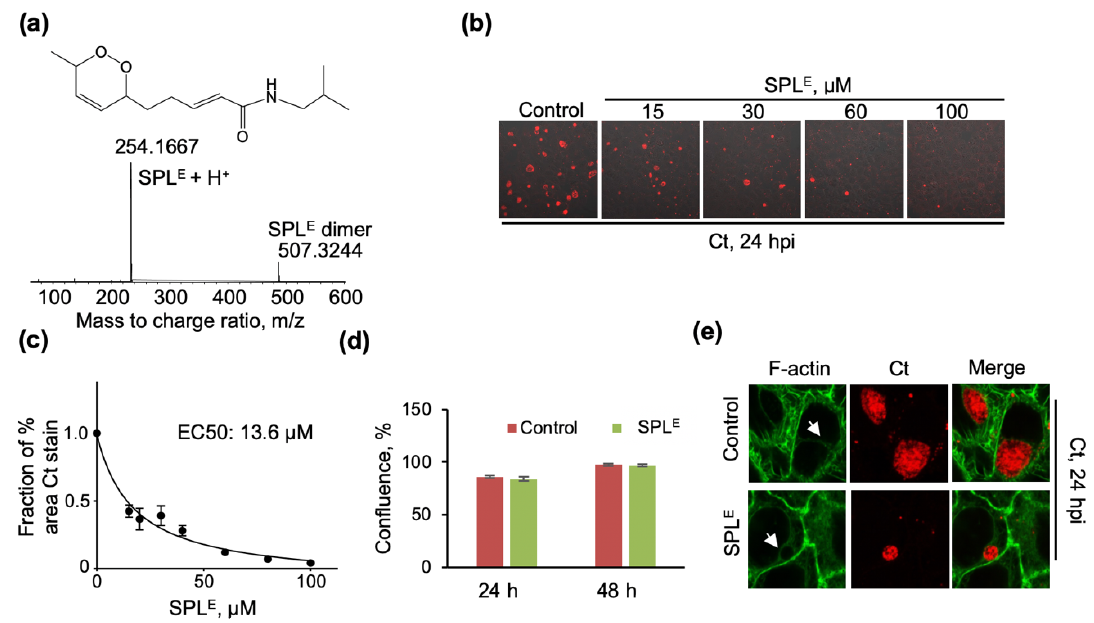
Figure 3. SPL E shows more potent inhibition of Ct infection ( a ) Chemical structure and ESI-TOF MS data of SPL E synthesized as described in Materials and Methods. MS data also shows the presence of SPL E dimer formed under the ESI-TOF MS conditions; ( b ) Confocal microscopy imaging of cells infected with Ct and SPL E vehicle (0.1% DMSO) at 24 hpi (control) or with SPL E followed immediately by infection with Ct and similarly imaged at 24 hpi. Chlamydial inclusions were visualized with anti-chlamydial major outer membrane protein (MOMP) antibody (red) and the image was overlayed with phase contrast images of cells; ( c ) Inhibition of Ct infection by SPL E was quantified by calculating the % area stained with anti-MOMP and representing the data as a fraction of vehicle control (n = 3 biological replicates, 3–6 imaging areas per biological replicate); ( d ) The effects of SPL E (120 μ M) on the proliferation of HeLa cells in the absence of Ct infection were quantified by analyzing the percent confluence over time using the IncuCyte ZOOM live-cell imager. The data at 24 and 48 h were extracted and plotted as bar graph. There was no statistically significant difference between control and SPL treatment conditions at either one of the time points (n = 3). ( e ) Disruption of F-actin cytoskeletal organization and Ct inclusions by SPL E (120 μ M). F-actin was detected with Alexa Fluor 488- phalloidin (green) and chlamydial inclusions were detected using anti-MOMP antibody (red). All imaging data are representative of a minimum two biological replicates and were collected at 40x magnification. White arrows point to the F-actin ring. 3.4. SPL E Reacts Predominantly with Mitochondrial Antioxidant Protein Peroxiredoxin (Prx3) Peroxiredoxins are key intracellular enzymes involved in detoxification of oxidants (e.g., H 2 O 2 ) and oxidized species (e.g., lipid peroxides), connecting phosphorylation and redox signaling [34]. These enzymes can be inactivated at high levels of H 2 O 2 or lipid peroxides during turnover leading to the formation of sulfinic acid at the catalytic peroxidatic cysteine (hyperoxidation) or by posttranslational modifications. The hyperoxidized inactive species can be repaired by sulfiredoxin (Srx), restoring their antioxidant activity. Amongst the 6 mammalian isoforms, Prx3 is located in the mitochondria and is the key regulator of mitochondrial H 2 O 2 . Prx1 and Prx2 belong to the same family of 2-Cys peroxiredoxins as Prx3, but are predominantly located in the cytosol. An increase in overall mitochondrial protein sulfenylation (Figure 2a,b) with SPL treatment could ensue if Prx3 is